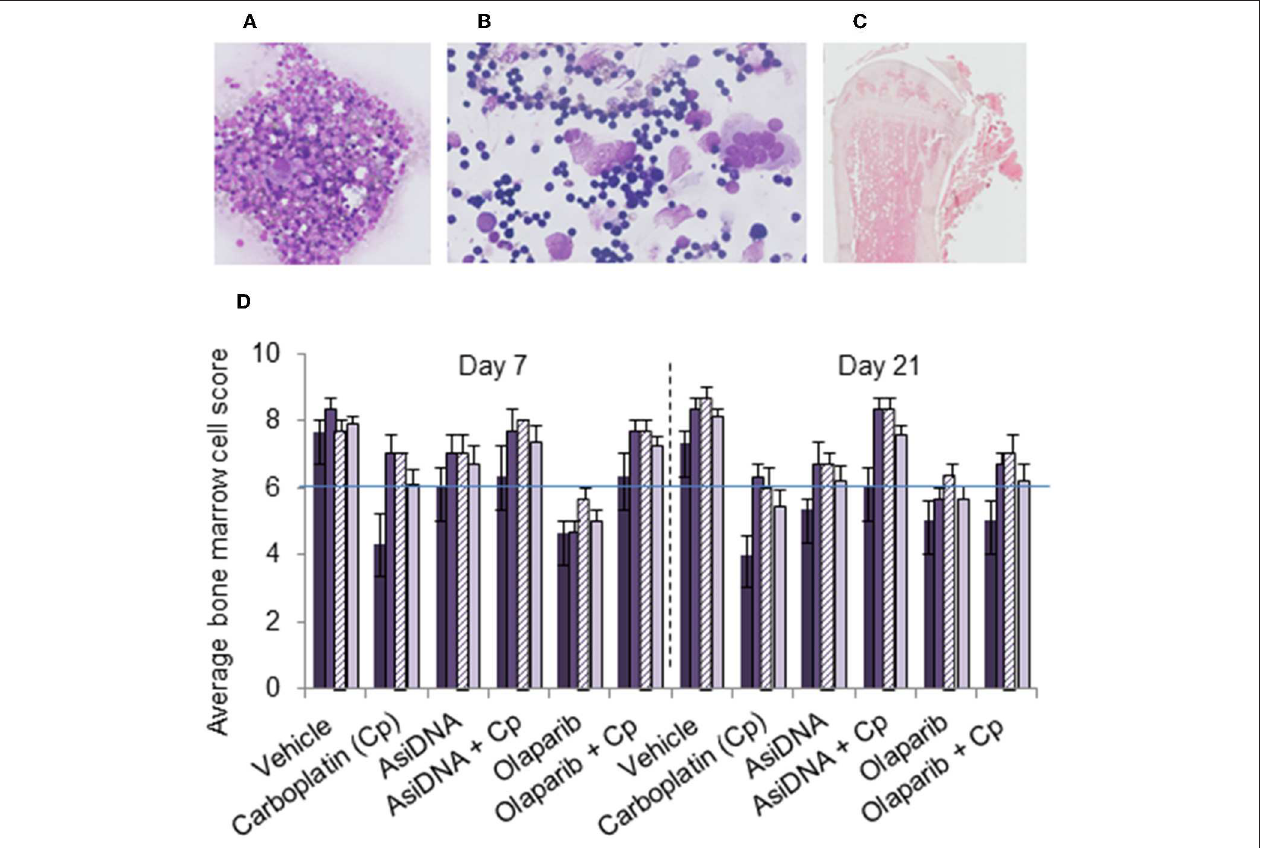
FIGURE 4 | Bone marrow myelogram. Wright–Giemsa staining of (A) sternal imprints and (B) bone marrow smears and (C) H&E staining of paraffin-embedded tibia. (D) Mean values of bone marrow myelogram (six animals) treated with various treatments (indicated in abscissa) and sacrificed at day 7 or day 21 after the third cycle. Samples were scored from 0 to 10 according to the following scale: poor (0–3), moderate (4–7), or good (8–10) indicating high, moderate, or no toxicity in erythroid (dark violet), myeloid (medium violet), and megakaryocyte score (dashed violet), and density (light